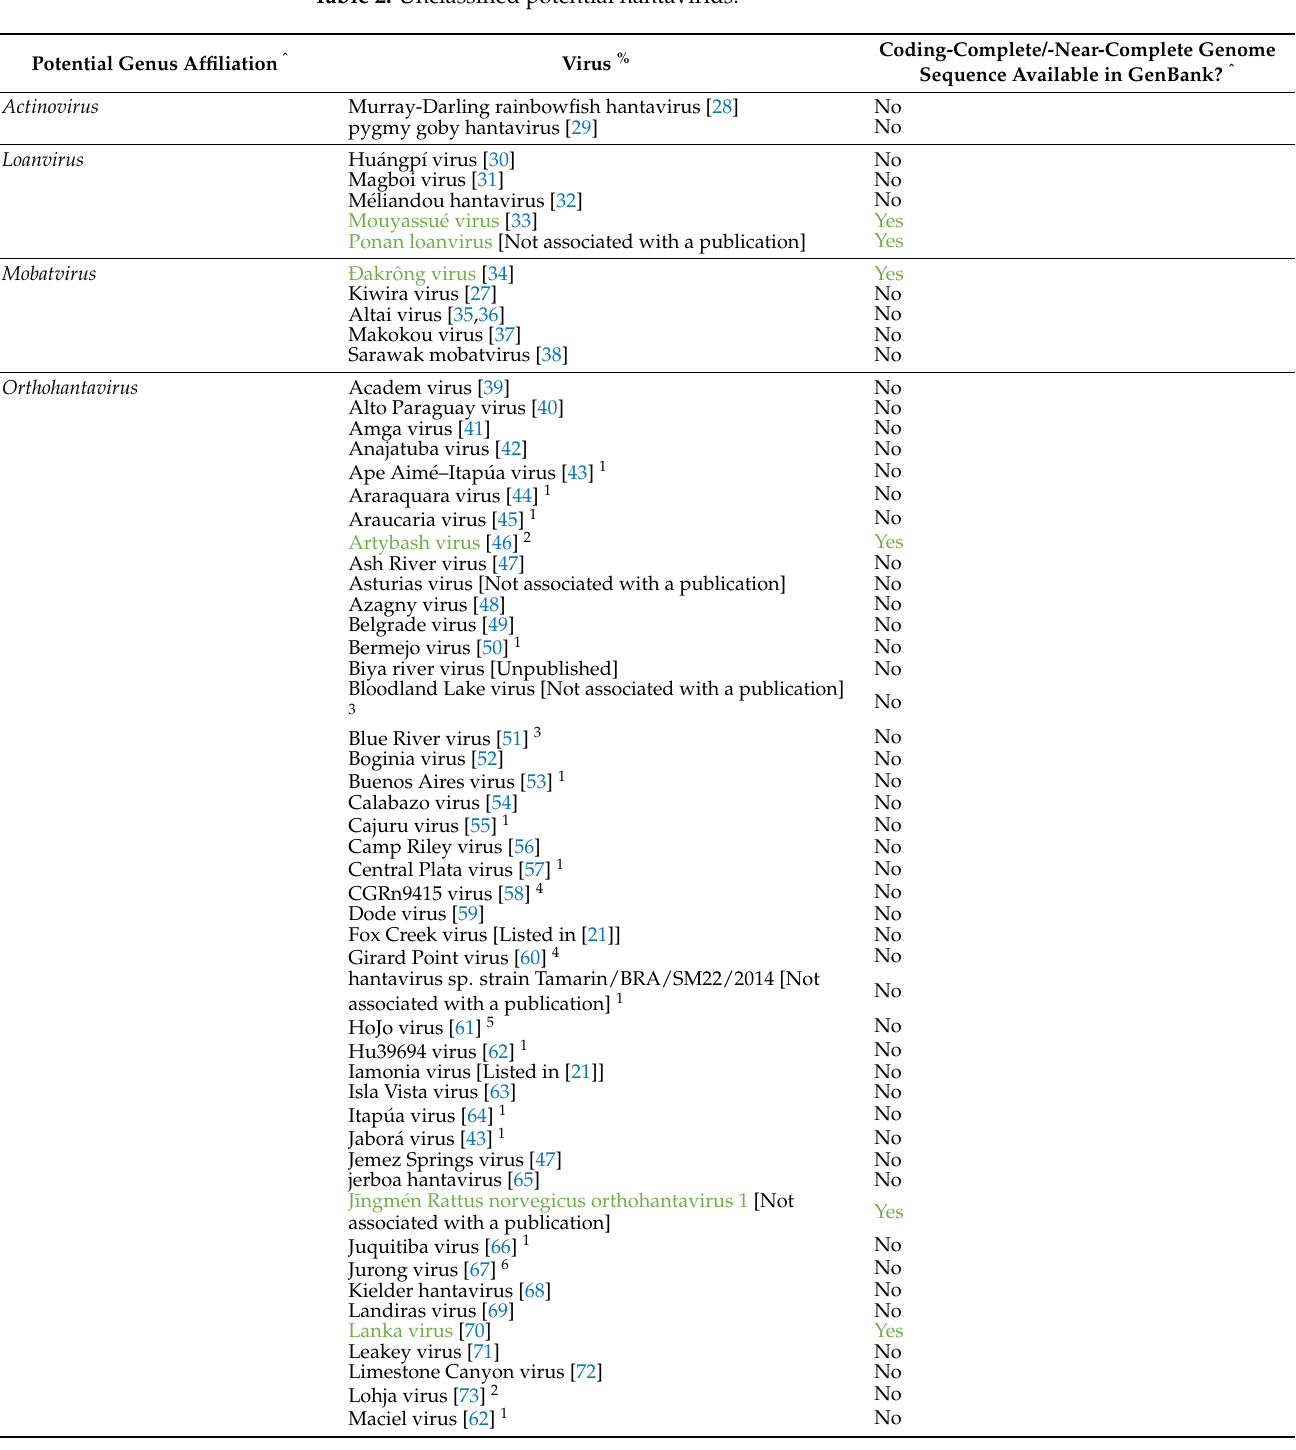
Table 2. Unclassified potential